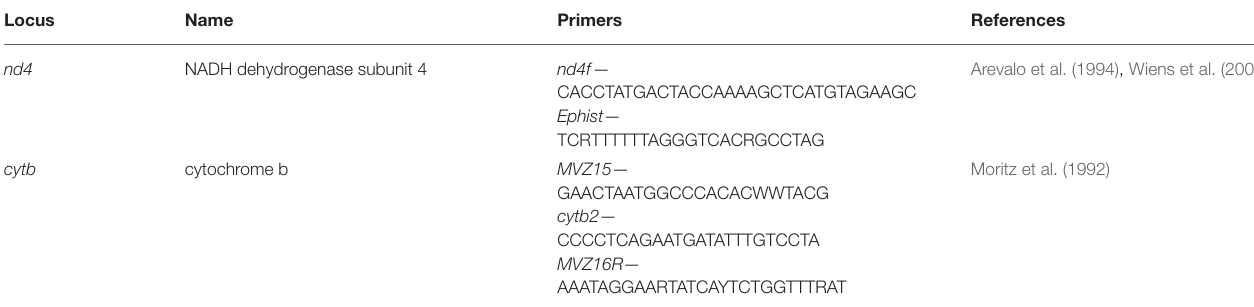
TABLE 2 | Mitochondrial loci and associated PCR primers to infer phylogenetic relationships of Aneides aeneus in the current study.